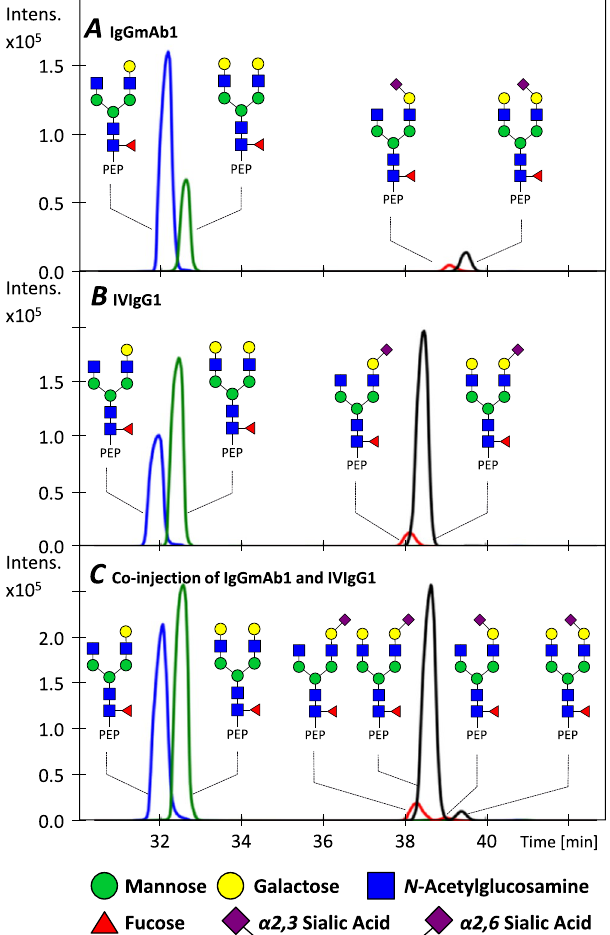
Figure 1. Extracted ion electropherograms (EIEs) of IgGmAb1 and IVIgG1 glycopeptides obtained with CE–ESI-MS after targeted alignment. ( A ) EIEs of IgGmAb1 glycopeptides derived from CHO cells, ( B ) EIEs of IVIgG1 retrieved from human plasma and ( C ) EIEs of a co-injection of IgGmAb1 and IVIgG1. The “PEP” label illustrates the tryptic peptide sequence EEQY N STYR to which the glycan is attached.